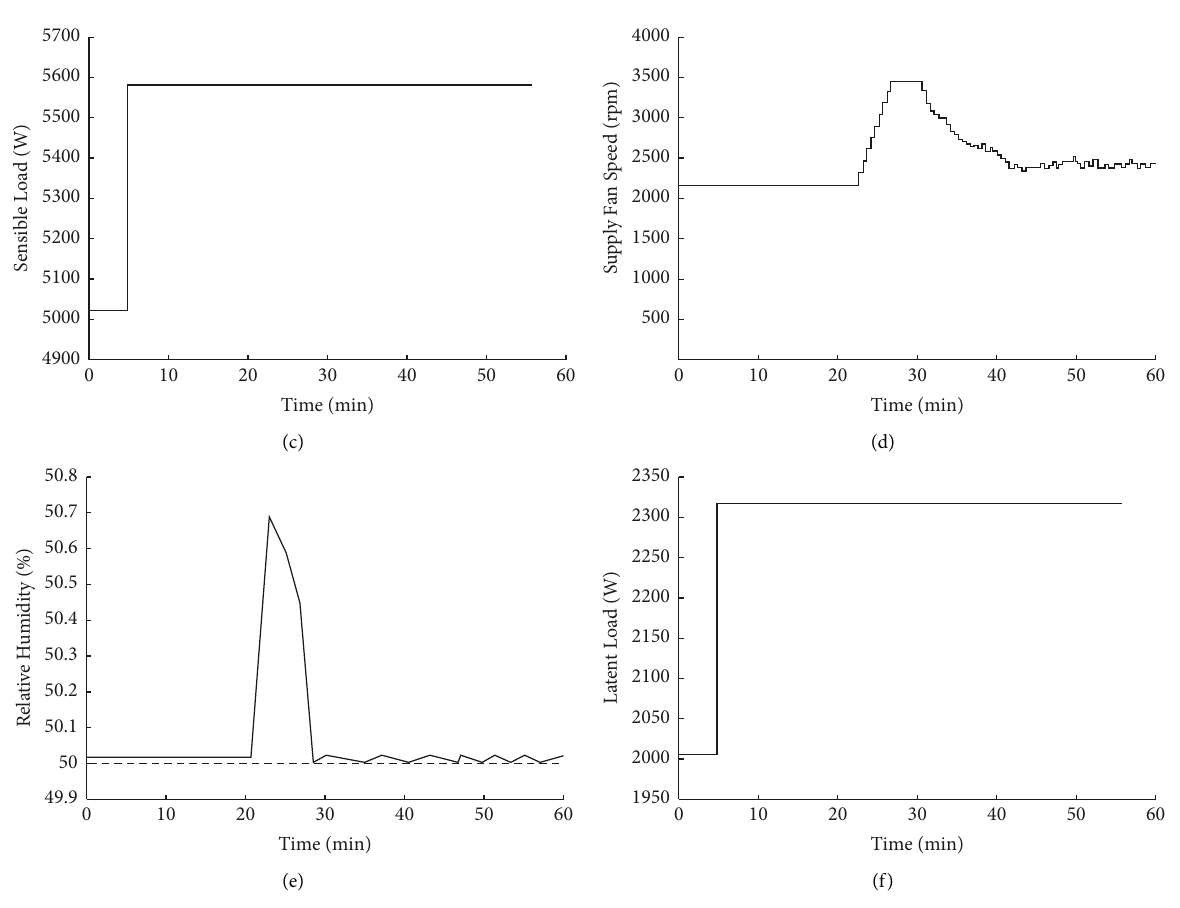
Figure 8: System responses to load